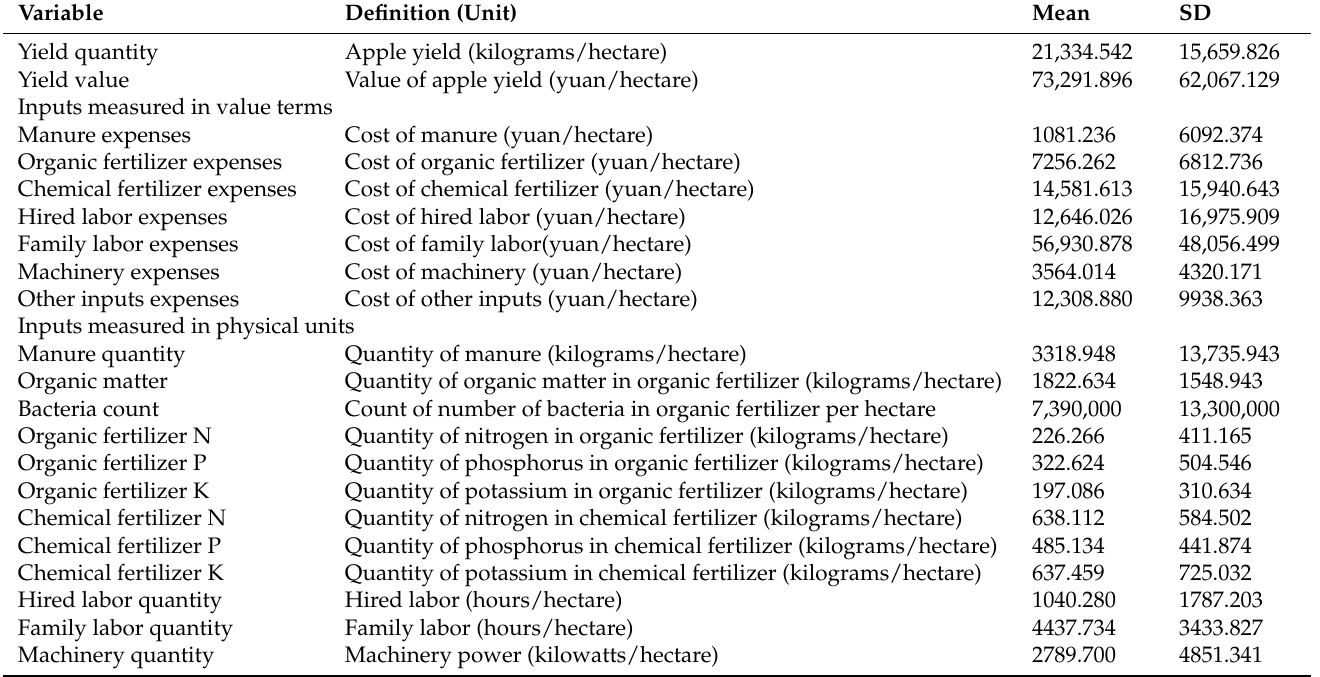
Table 1. Inputs and outputs: definitions and summary